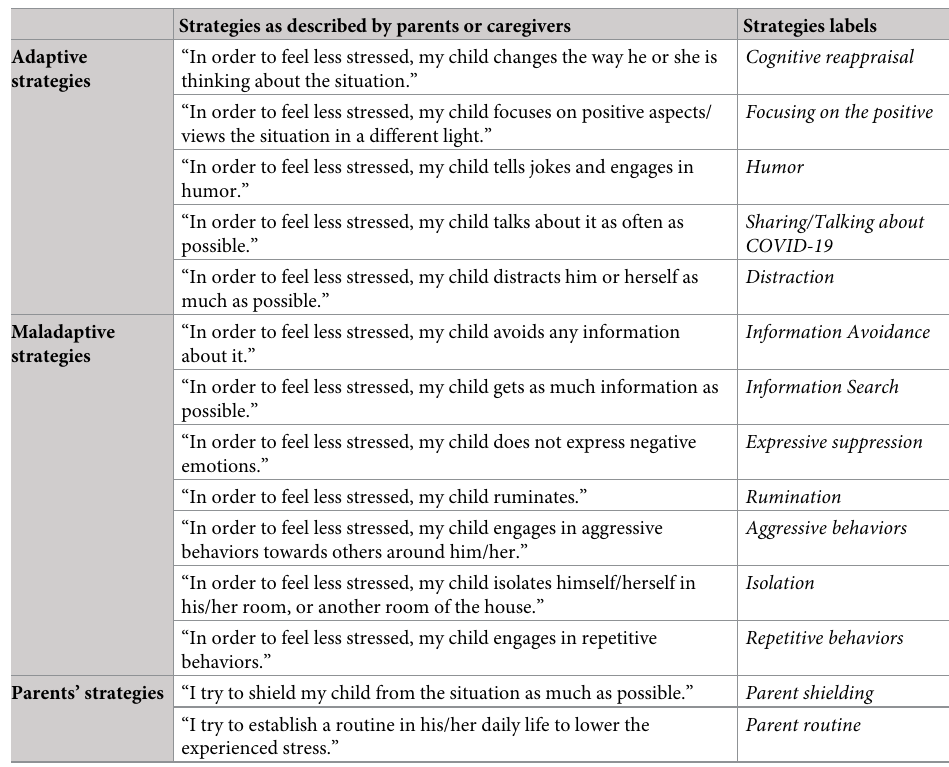
Table 2. Categorization of surveyed coping